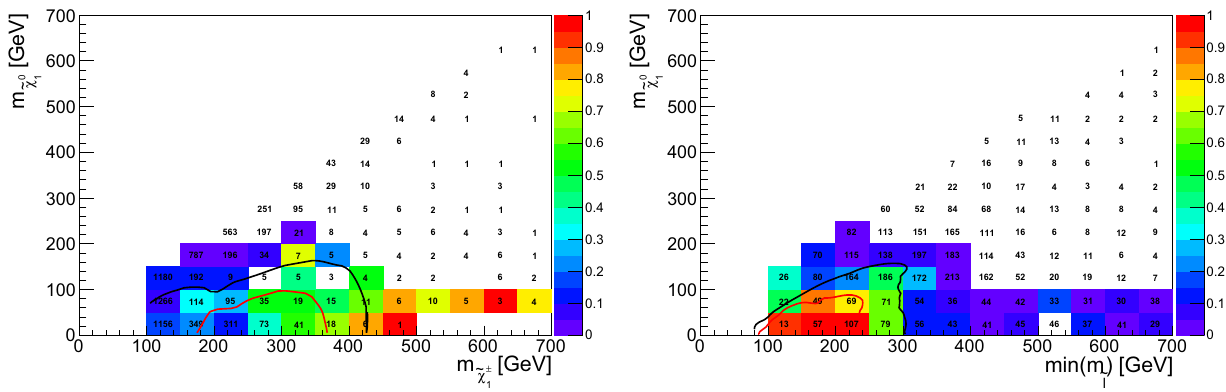
Fig. 12 Coverage in the plane of lightest slepton (first two genera- tions) vs. LSP mass, for ˜ l masses up to 700 GeV. Here, bino-like and higgsino-like LSP scenarios have been combined to increase the num- ber of points. The plot on the left considers all analyses, the plot on the Fraction of Bino+Higgsino LSP ATLAS EW excluded points excluded by SModelS EW (r>0.8)